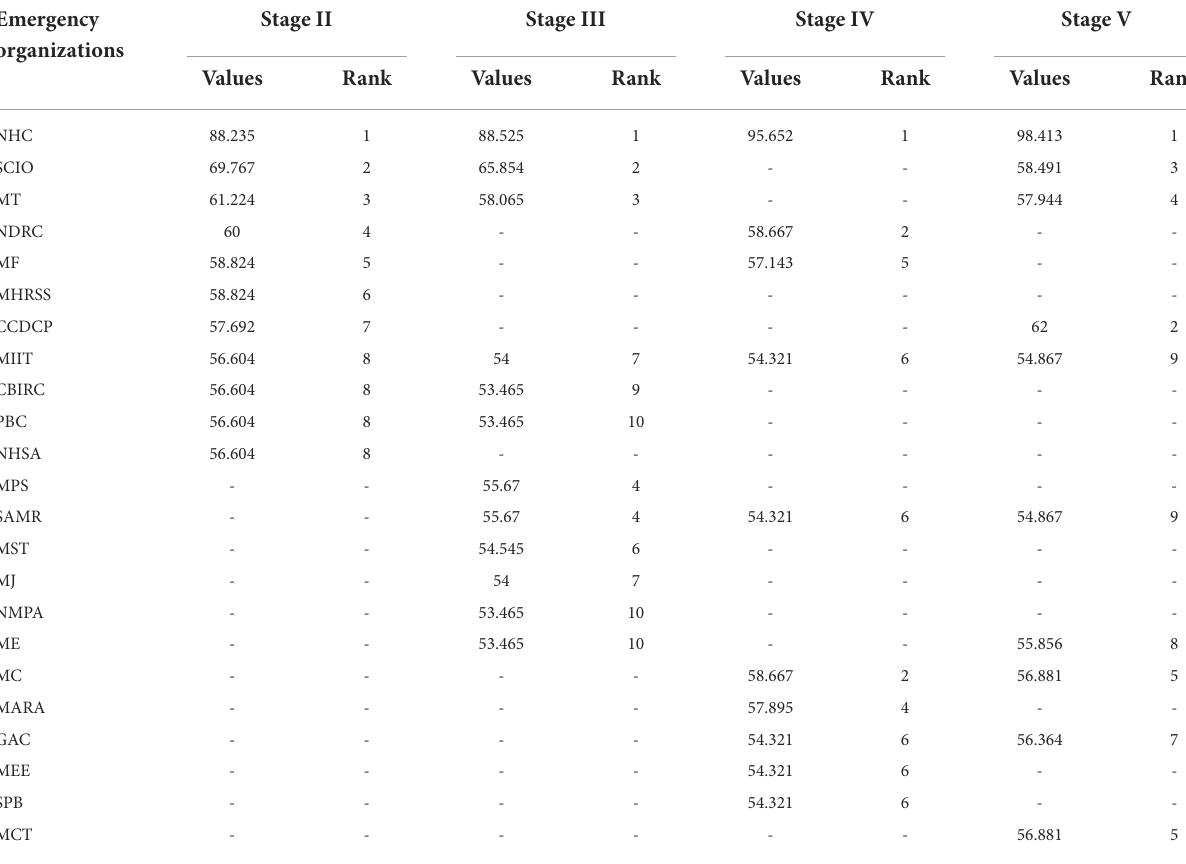
TABLE 6 Top 10 EOs with the normalized closeness centrality in Stages